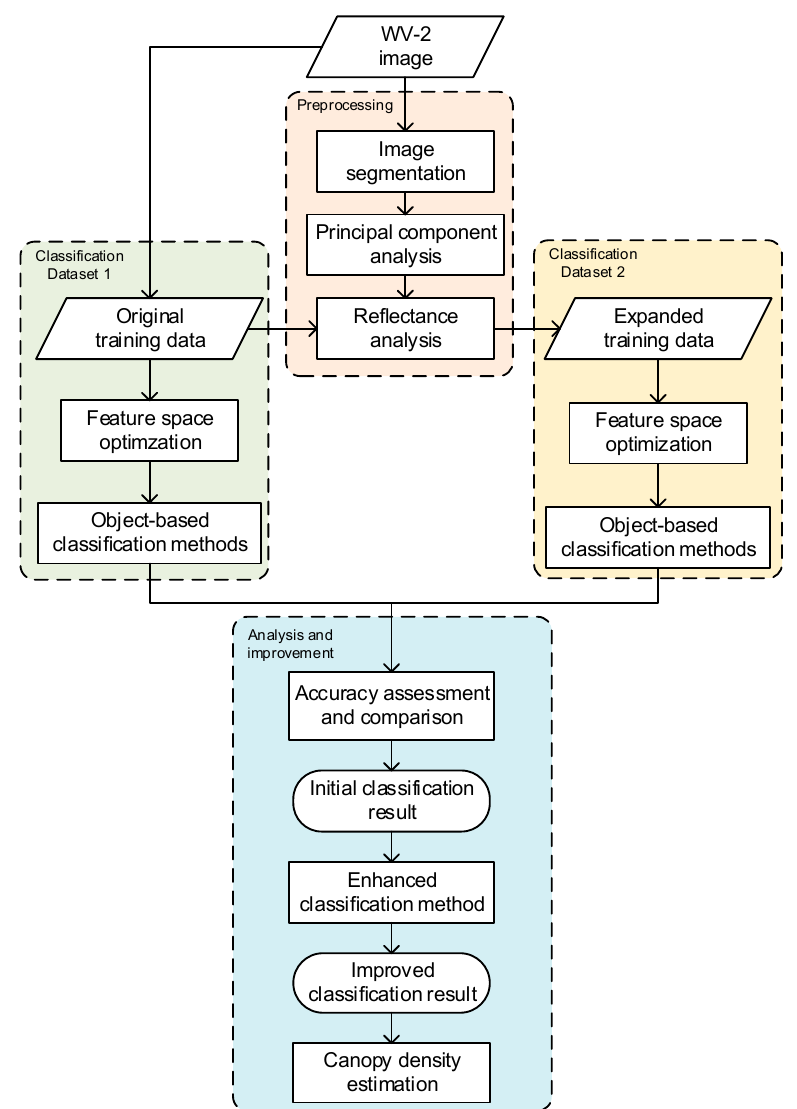
Figure 2. Flowchart of the classification process.